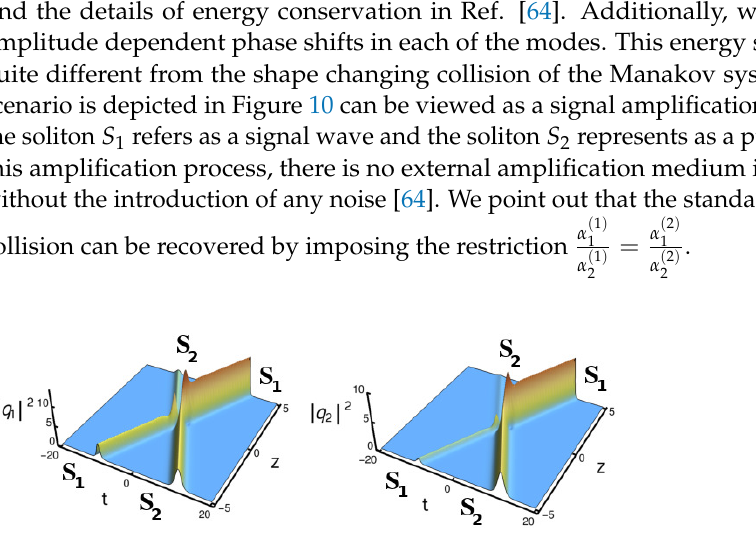
Figure 10. Energy sharing collision of degenerate two bright solitons of the mixed 2-CNLS system